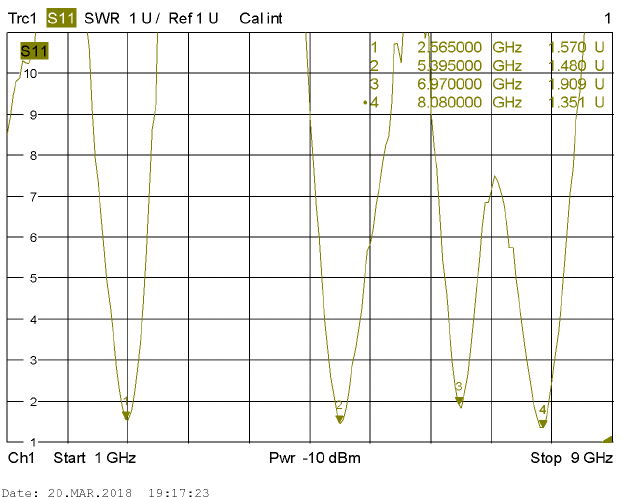
Figure 10. Measured VSWR of the proposed